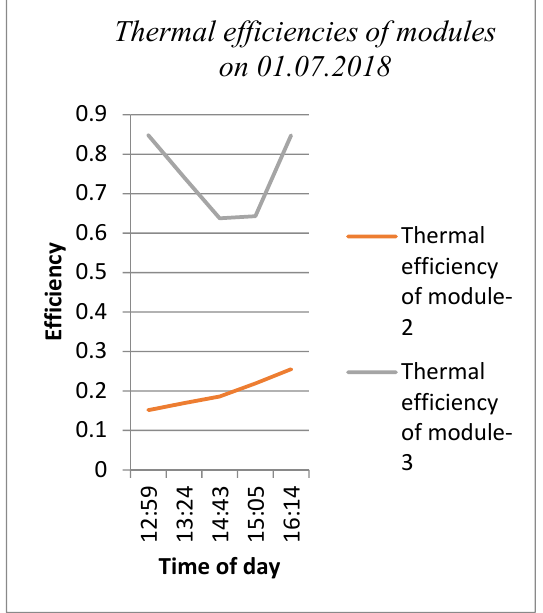
Figure 15. Thermal efficiencies of modules on 01.07.2018.